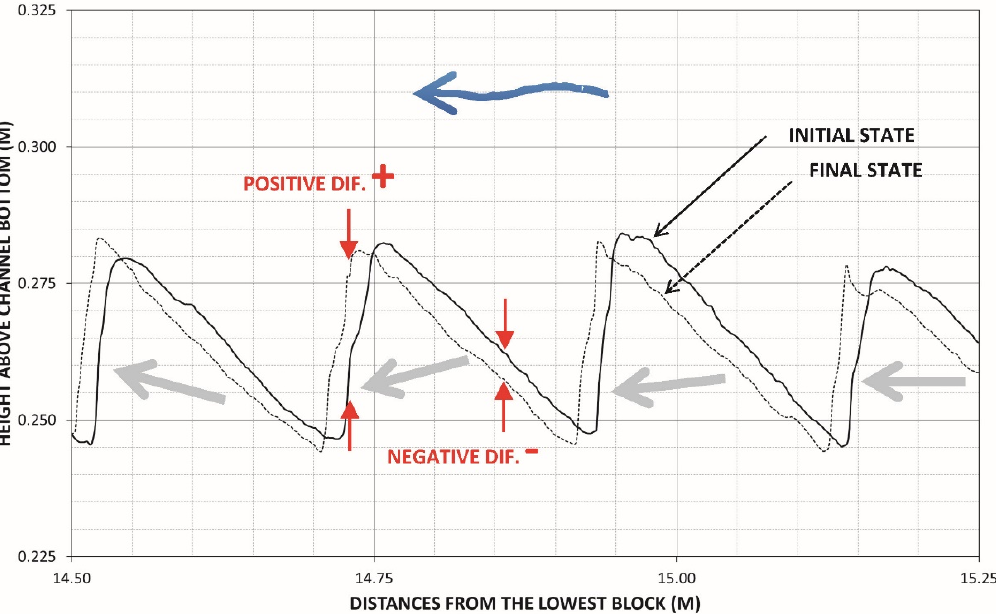
Figure 21. Support scheme for the interpretation of the values obtained (the blue arrow indicates the direction of the flow).